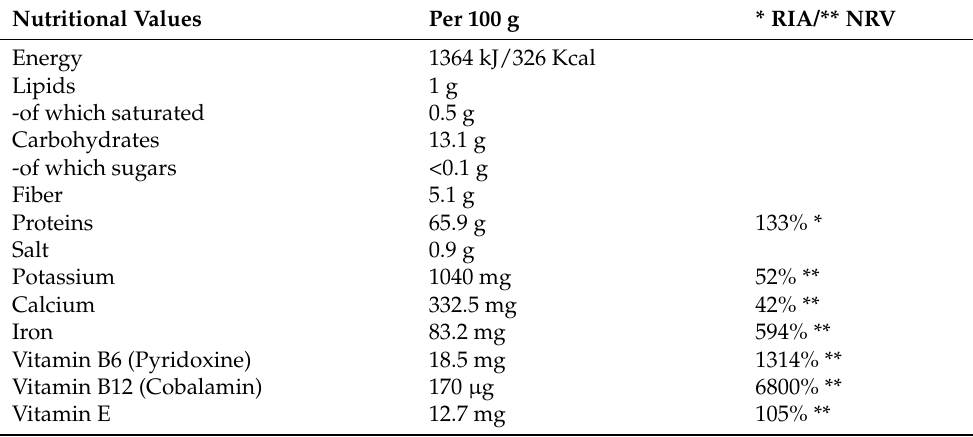
Table 1. Constituents of Spirulina platensis . Average nutritional analysis per 100 g. Nutritional Values Per 100 g * RIA/**